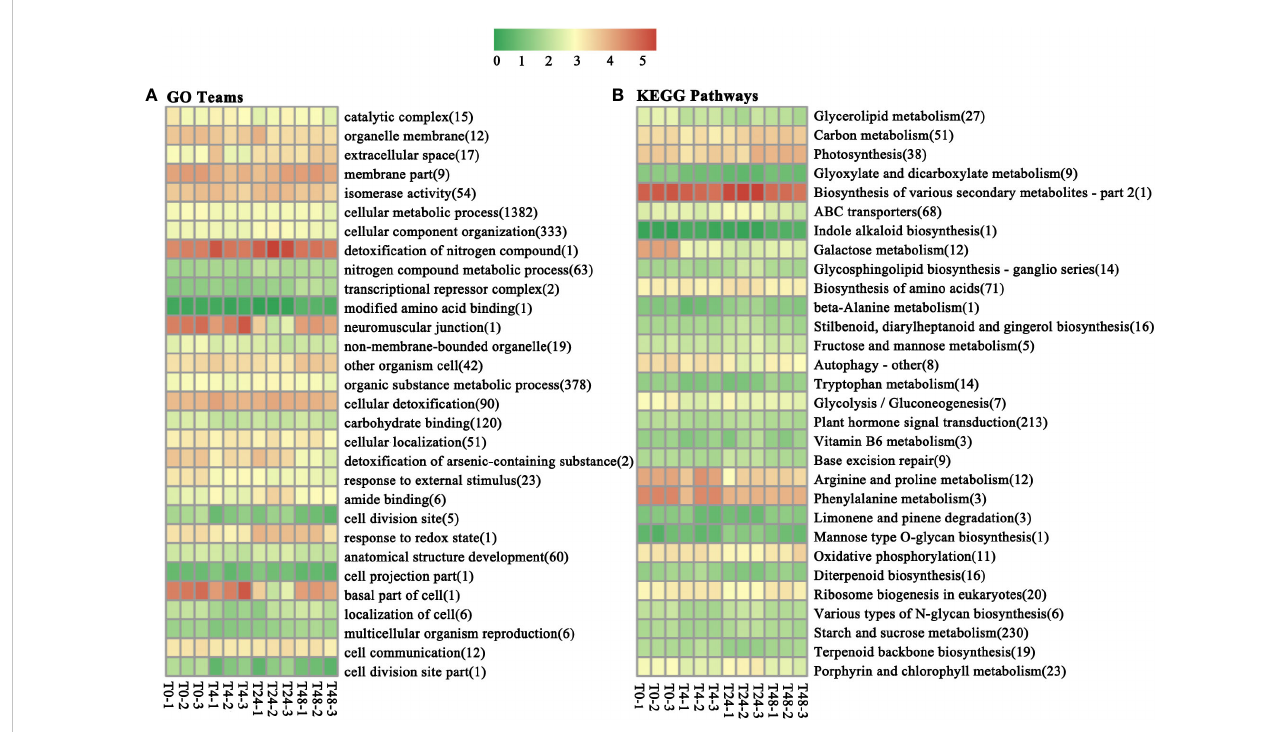
FIGURE 3 Under aluminum stress, 30 GO terms and KEGG pathways were enriched for the most DEGs. (A) GO teams. (B) KEGG pathways. The numbers in the abscissa represent the number of DEGs enriched for the GO term or KEGG pathway. T0 to T48 represent M. truncatula plant samples treated with aluminum for 0h, 4h, 24h, and 48h, respectively. The comparison is described as A vs B, which means the DEG was found in the A treatment relative to the B